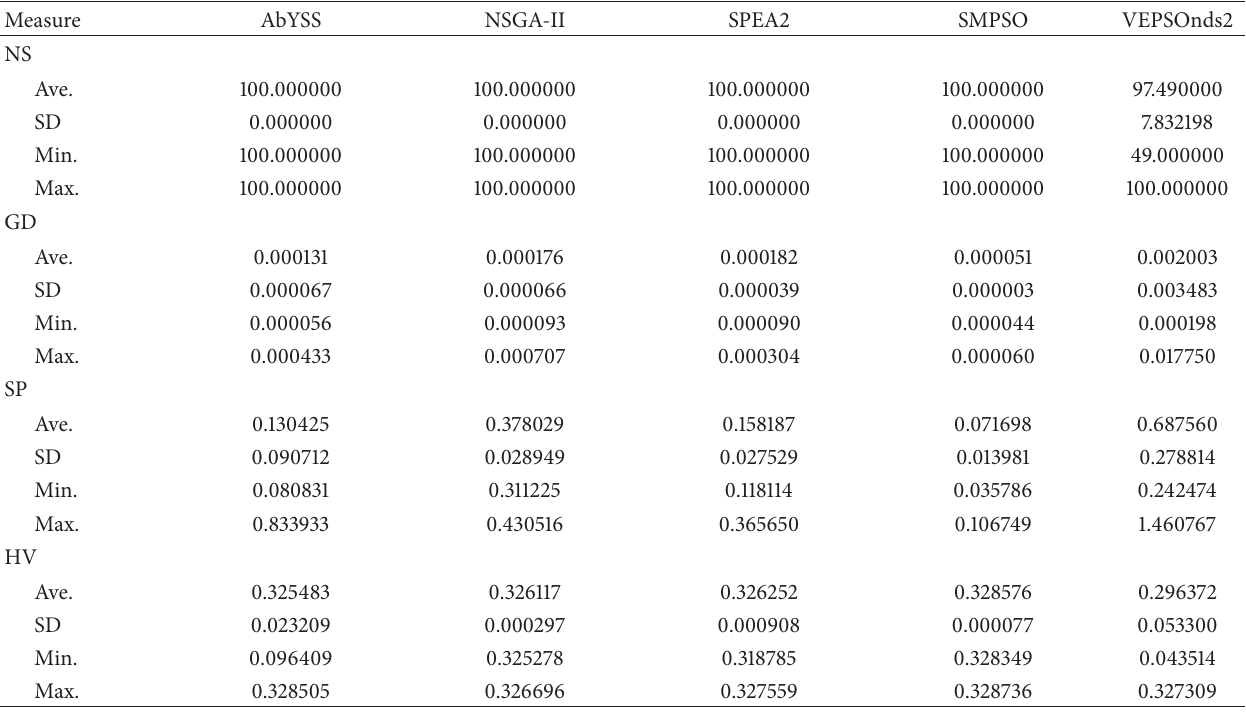
Table 7: Performance comparison based on ZDT2 test